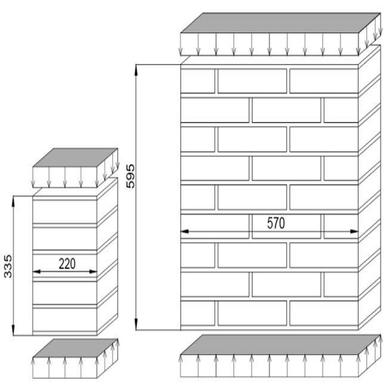
Masonry prism and panel subjected to uniaxial compressive load (dimensions in mm).